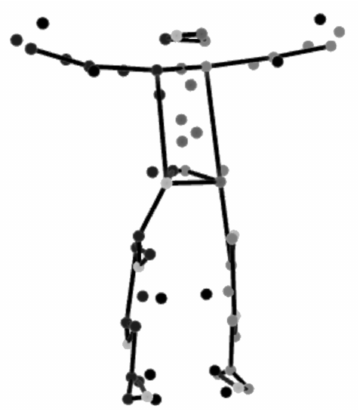
Figure 1. Marker locations of the Cleveland Clinic Marker set [16], including clusters on the lower limbs and calibration markers during static calibration of an